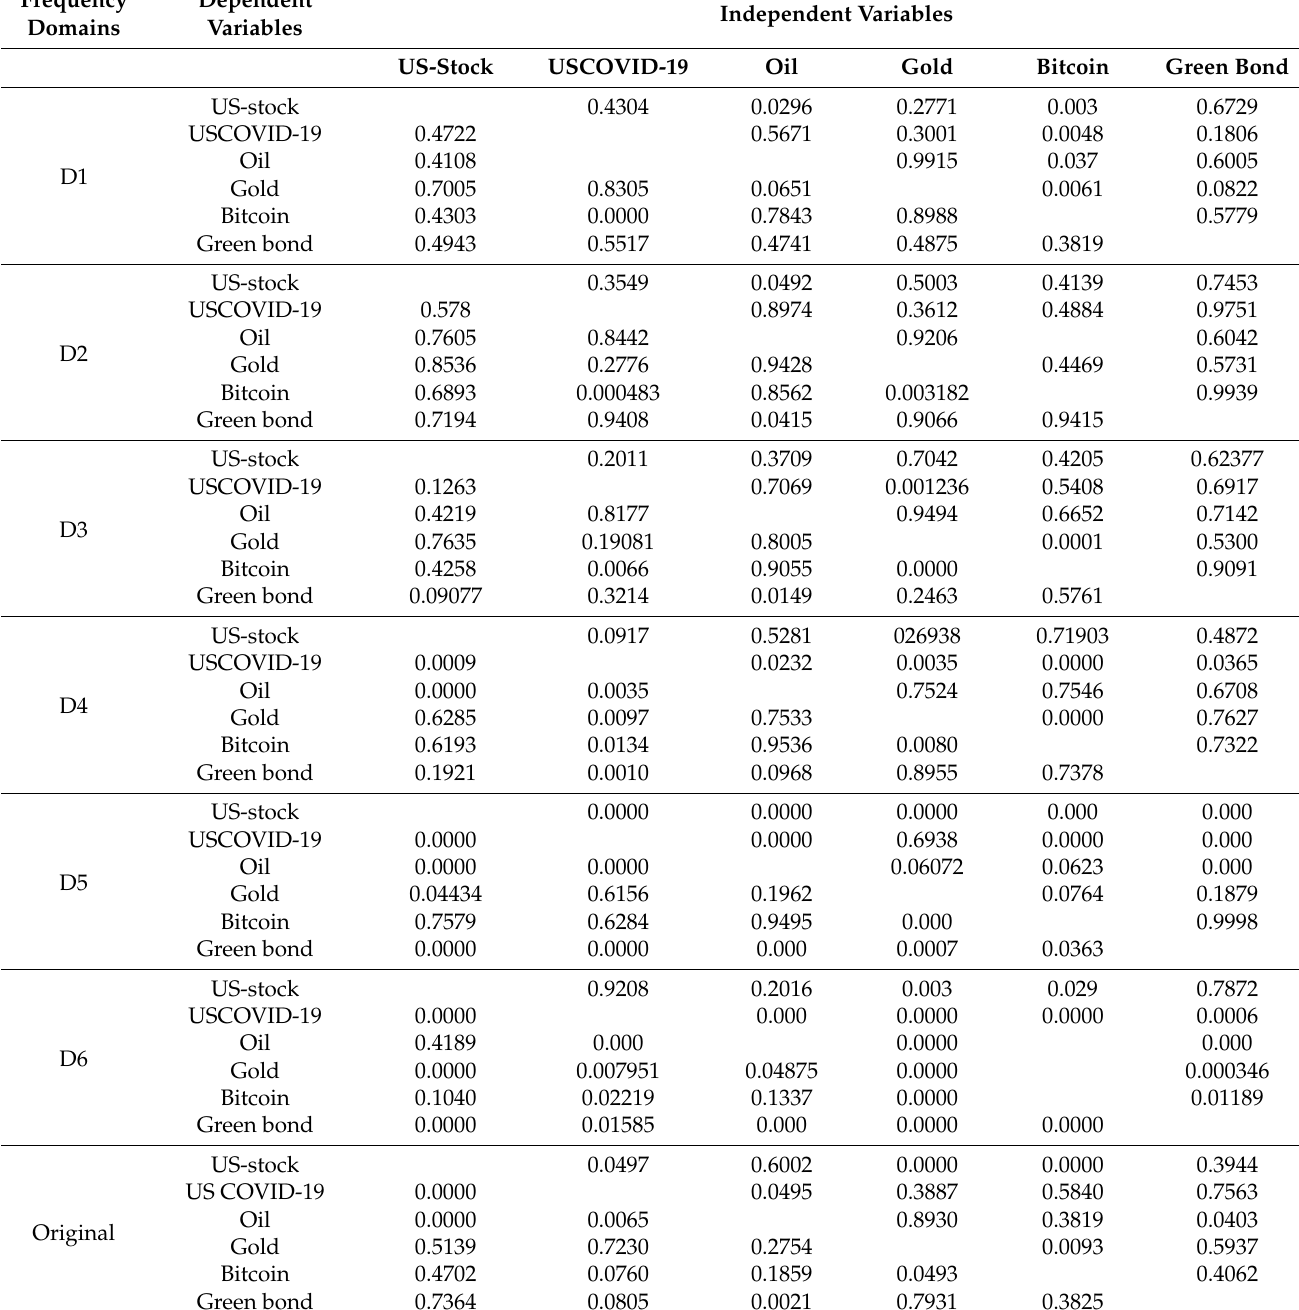
Table 2. The results for six sub frequency domains